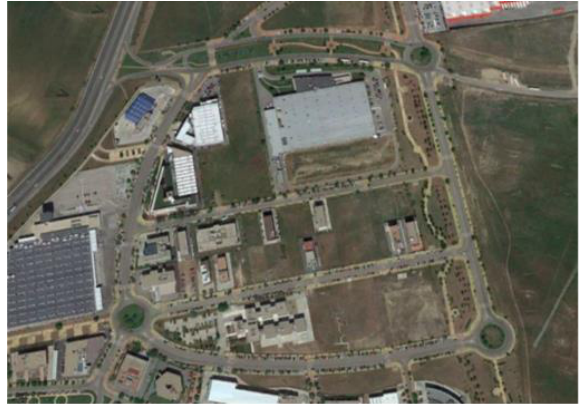
Figure 4. Experiments’ context (Map scale 1:7800 cm).